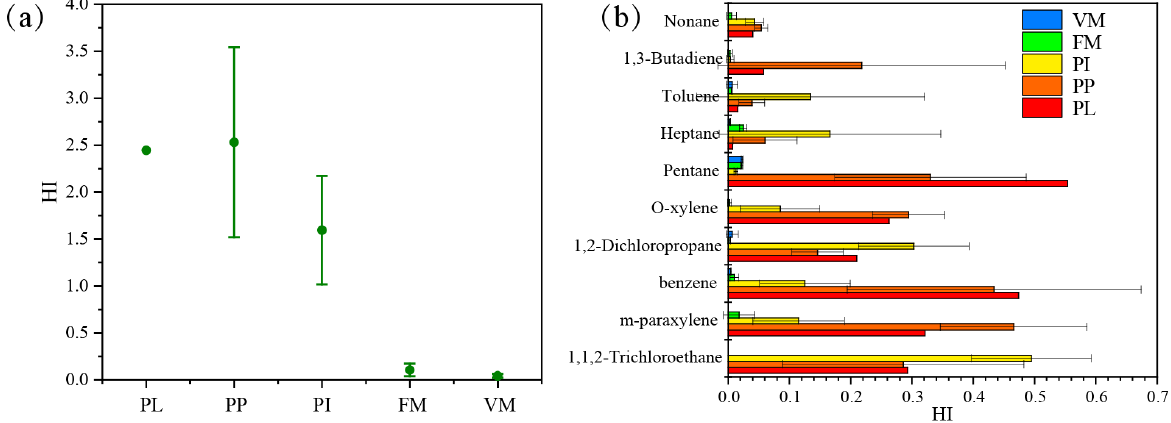
Figure 6. HI ( a ) and VOC ( b ) components of priority control in different industries.